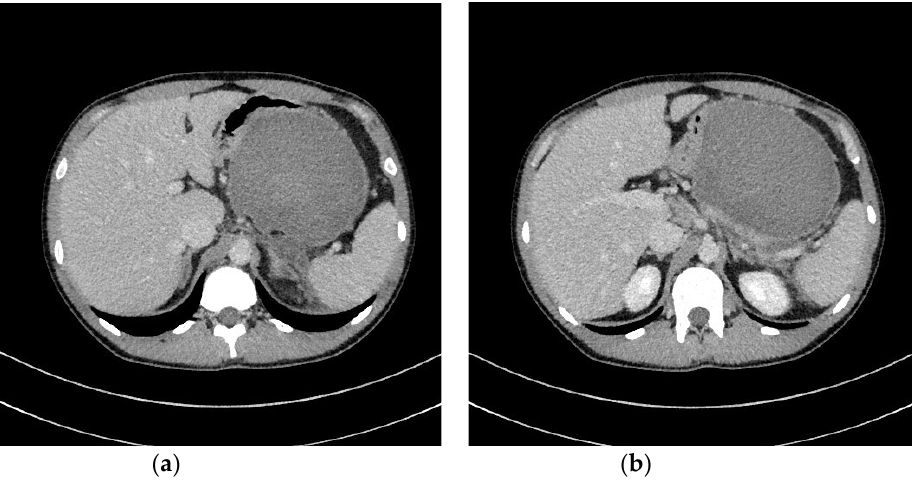
Figure 2. ( a , b ) Abdominal CECT was obtained in the same patient (Figure 1a,b) five weeks after the episode of ANP. A WOPN is visible, indenting the gastrointestinal wall. ANP, acute necrotizing pancreatitis; CECT, contrast-enhanced computed tomography; WOPN, walled-off pancreatic necrosis.